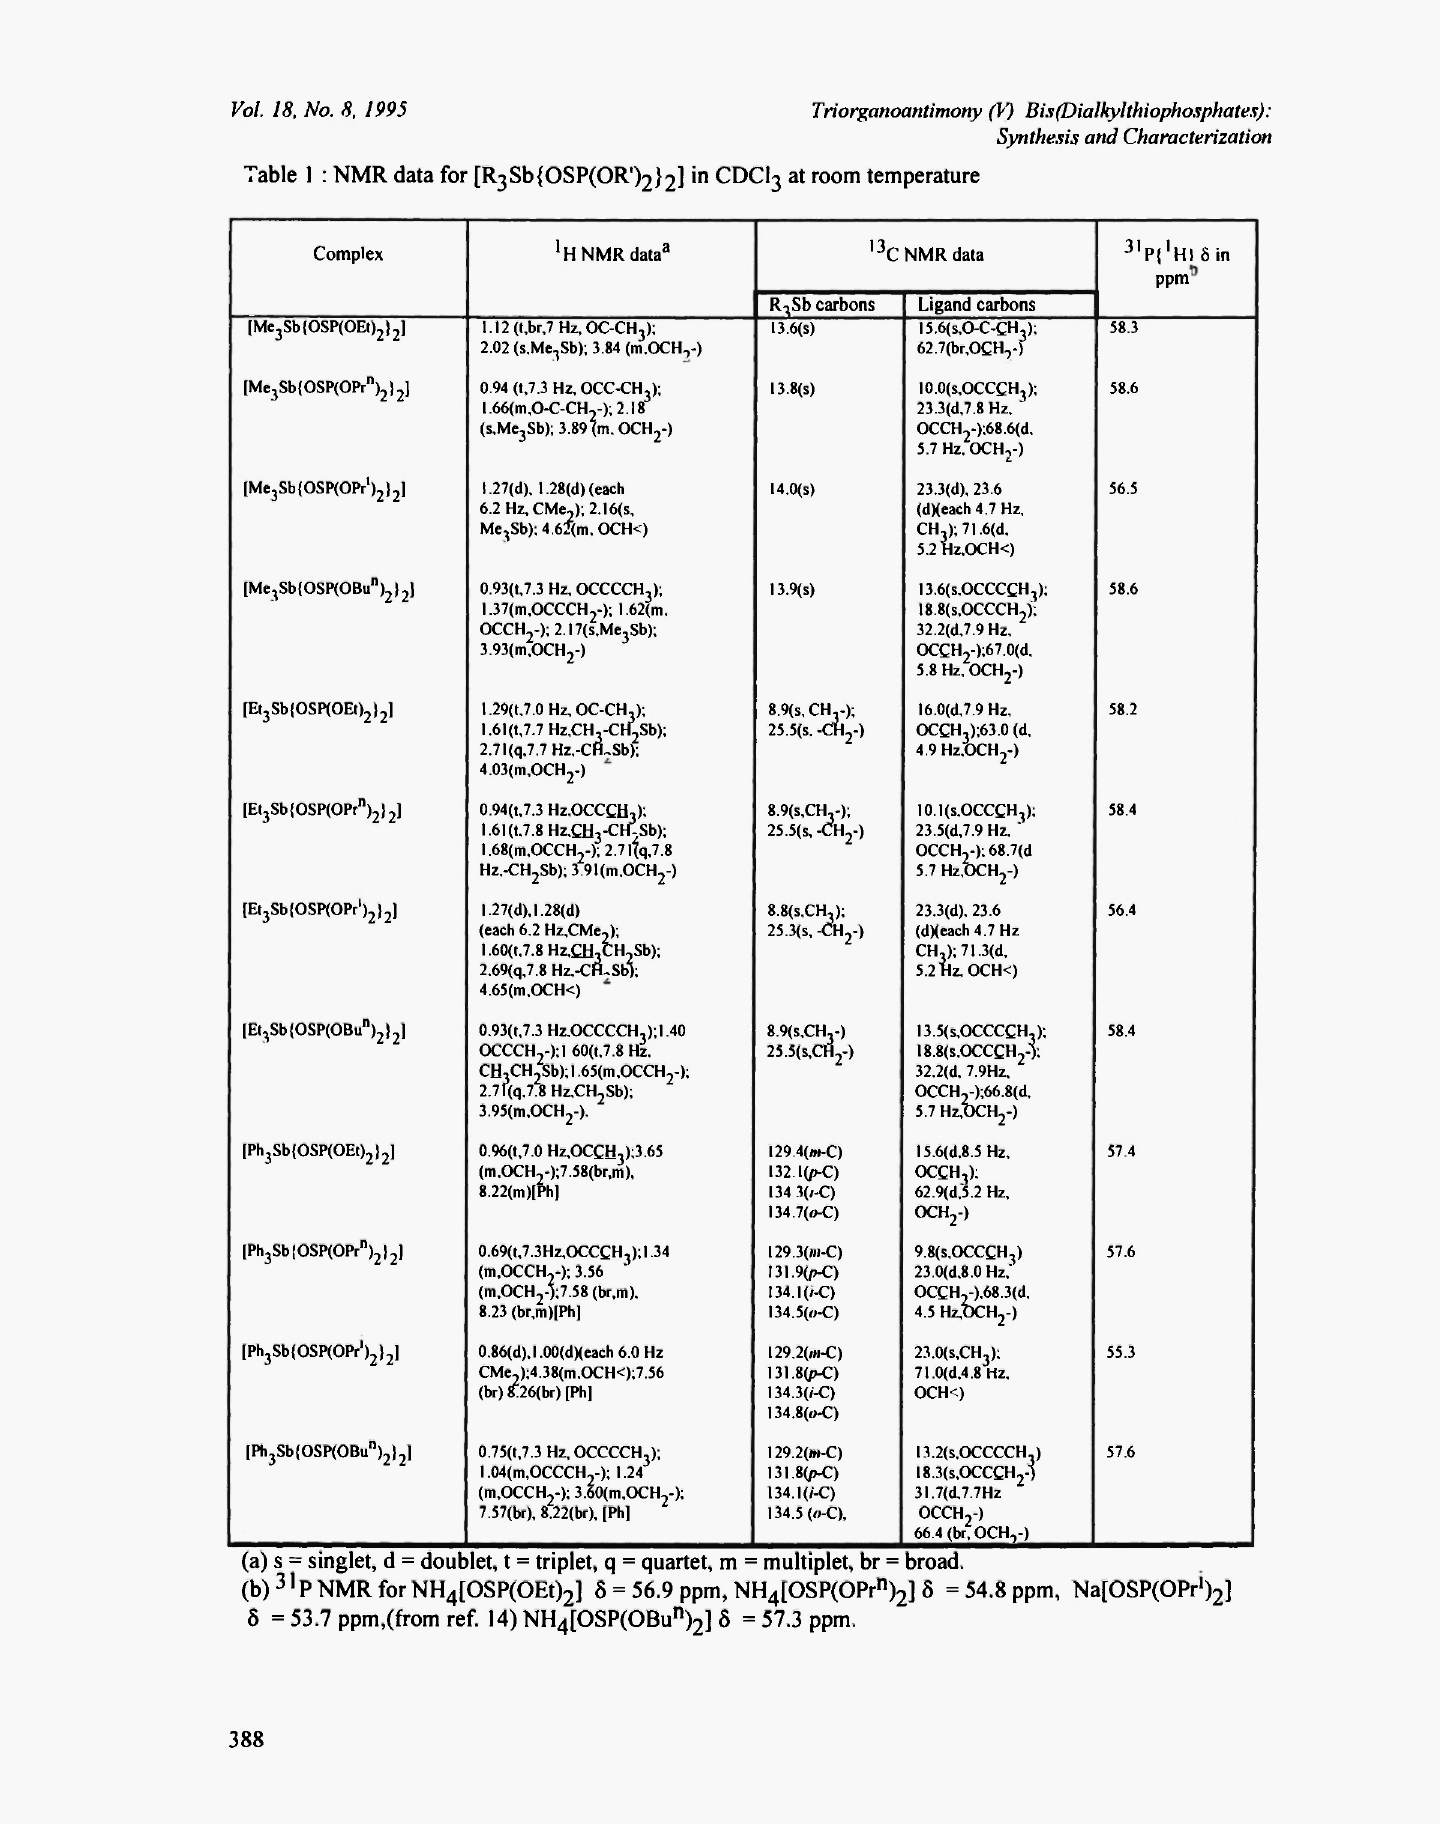
Table 1 : NMR data for [R 3 Sb{OSP(OR') 2 } 2 ] in CDCI3 at room temperature